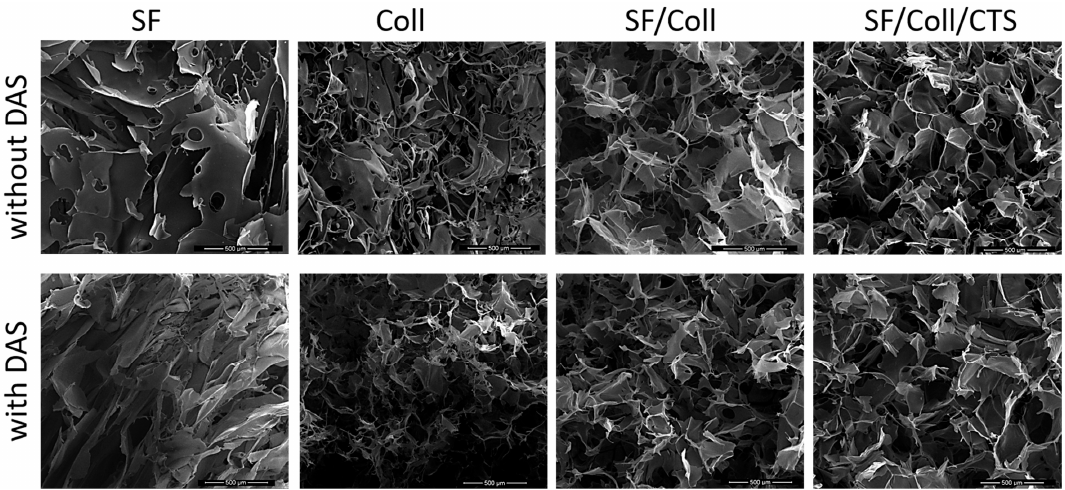
Figure 1. SEM images of every scaffolds with scale bar 500 µm. Polymers 2020 , 12 , x FOR PEER REVIEW